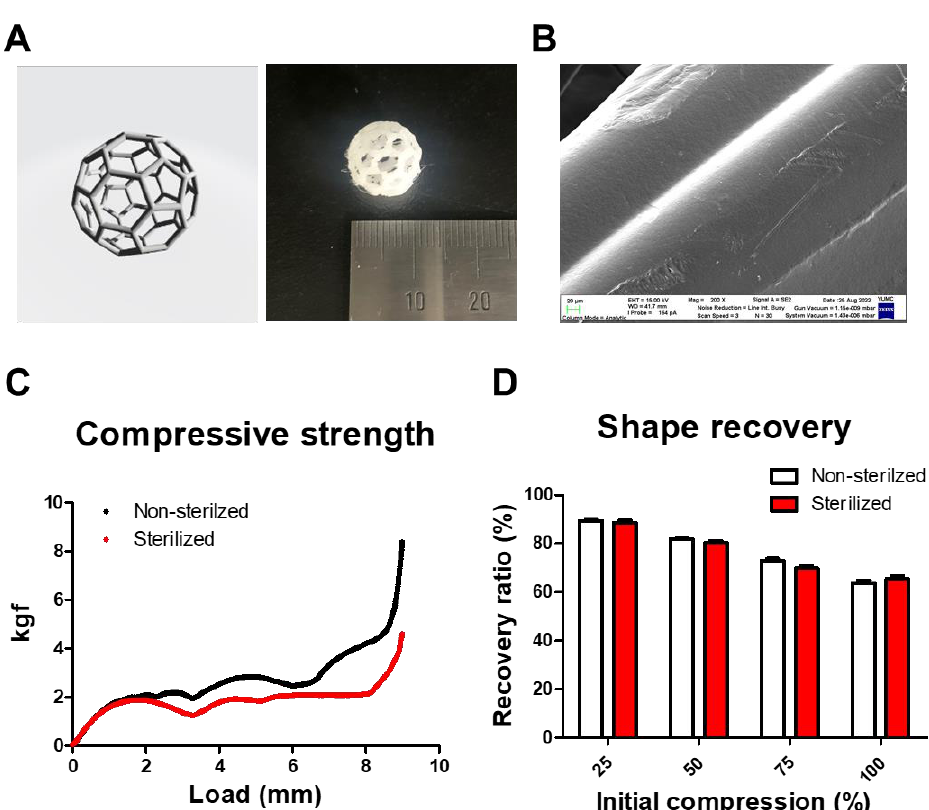
Figure 1. Fabrication of the PCL scaffold for partial mastectomy. ( A ) Design image of the PCL scaffold and polygon structure that was printed in PCL filament. ( B ) Scanning electron microscopy image of the PCL scaffold (Scale bar = 100 µ m). ( C ) Compressive strength of the PCL scaffold. ( D ) Shape recovery ability of PCL scaffolds.